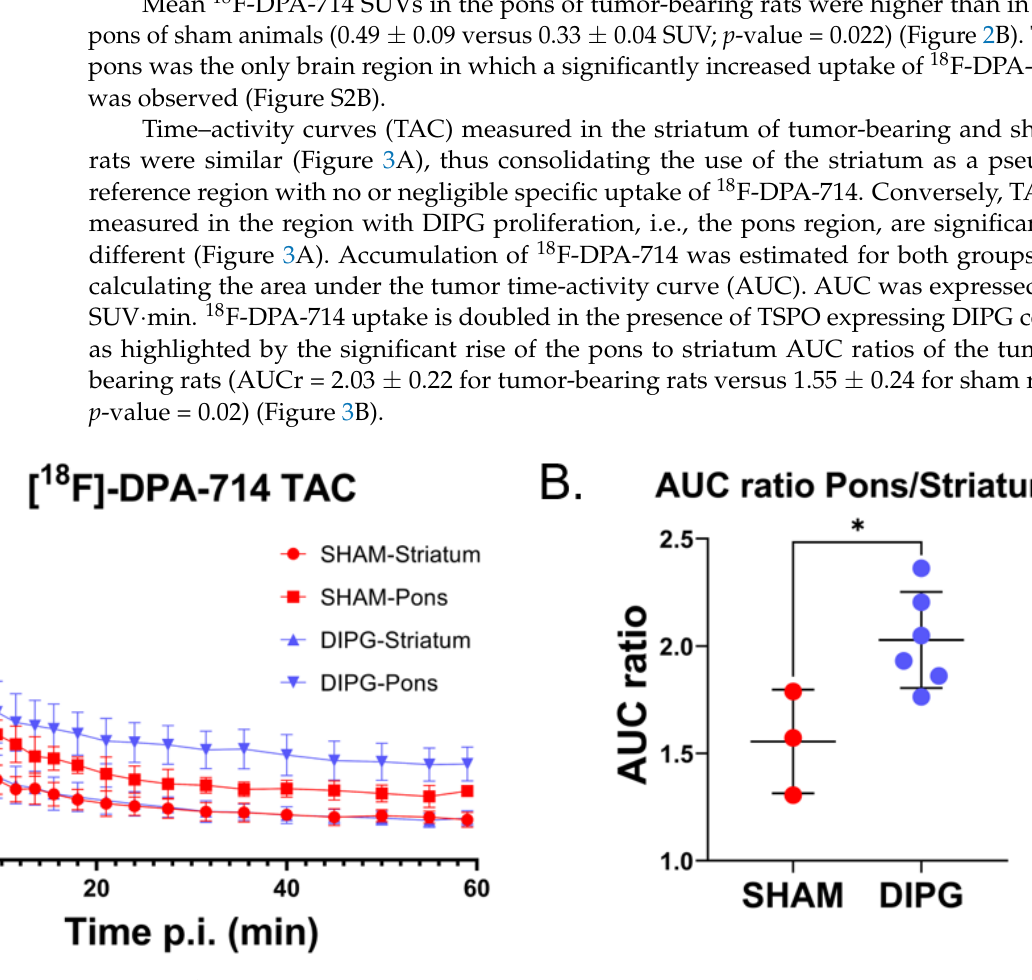
Figure 3. 18 F-DPA-714 uptakes in the pons and the striatum over time post injection. ( A ) Time activity curves (TAC) of 18 F-DPA-714 in different brain structures of sham and tumor-bearing rats. ( B ) Individual area under the curves (AUC) pons to striatum ratio. Statistical significance was determined using t -test with * p < 0.05. Data are represented as individual data and mean ± SD.